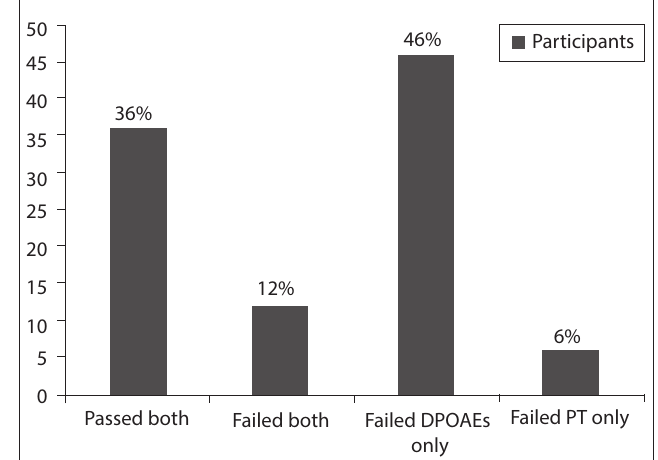
Fig. 1. Overall results of all participants.